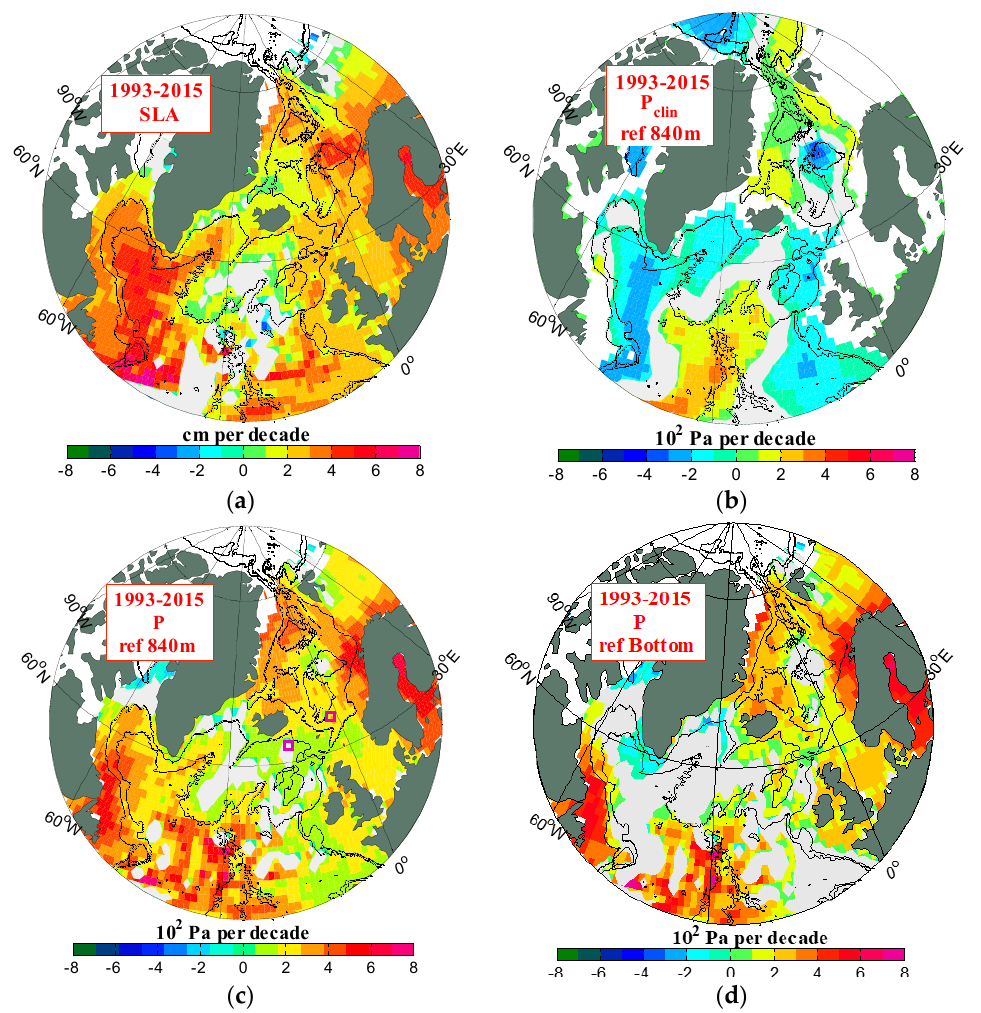
Figure 4. SLA ( a ), Pclin_840 ( b ), P_840 ( c ), P_bottom ( d ) changes trends from 1993 to 2015. The gray area represents the sea area that has not passed the 95% significance test; the white area represents the sea area where the period of missing data is longer than 7 years. The black lines are the 1000 and 3000 m isobaths; the purple square represents the selected point for calculating the pressure difference between the two sides of the GSR in panel ( c ).